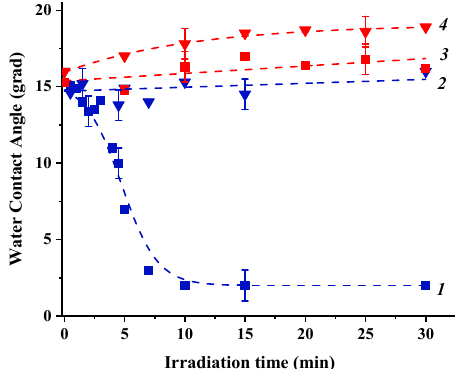
Figure 4. Kinetics of alteration of the water contact angle on the surfaces of ZnO (1 and 3) and ZnO/Cu 2 O (2 and 4) coatings under UV (1 and 2) and visible (3 and 4) light irradiation.